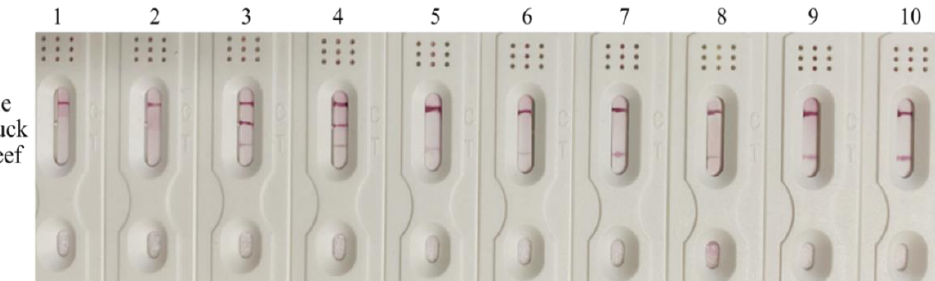
Figure 5. Detection results of real commercial processed meat samples. Lane 1–2: Blank; Lane 3–4: 50%